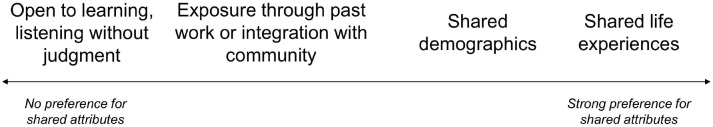
Participant preferences for mechanism by which case managers develop sociocultural understanding.